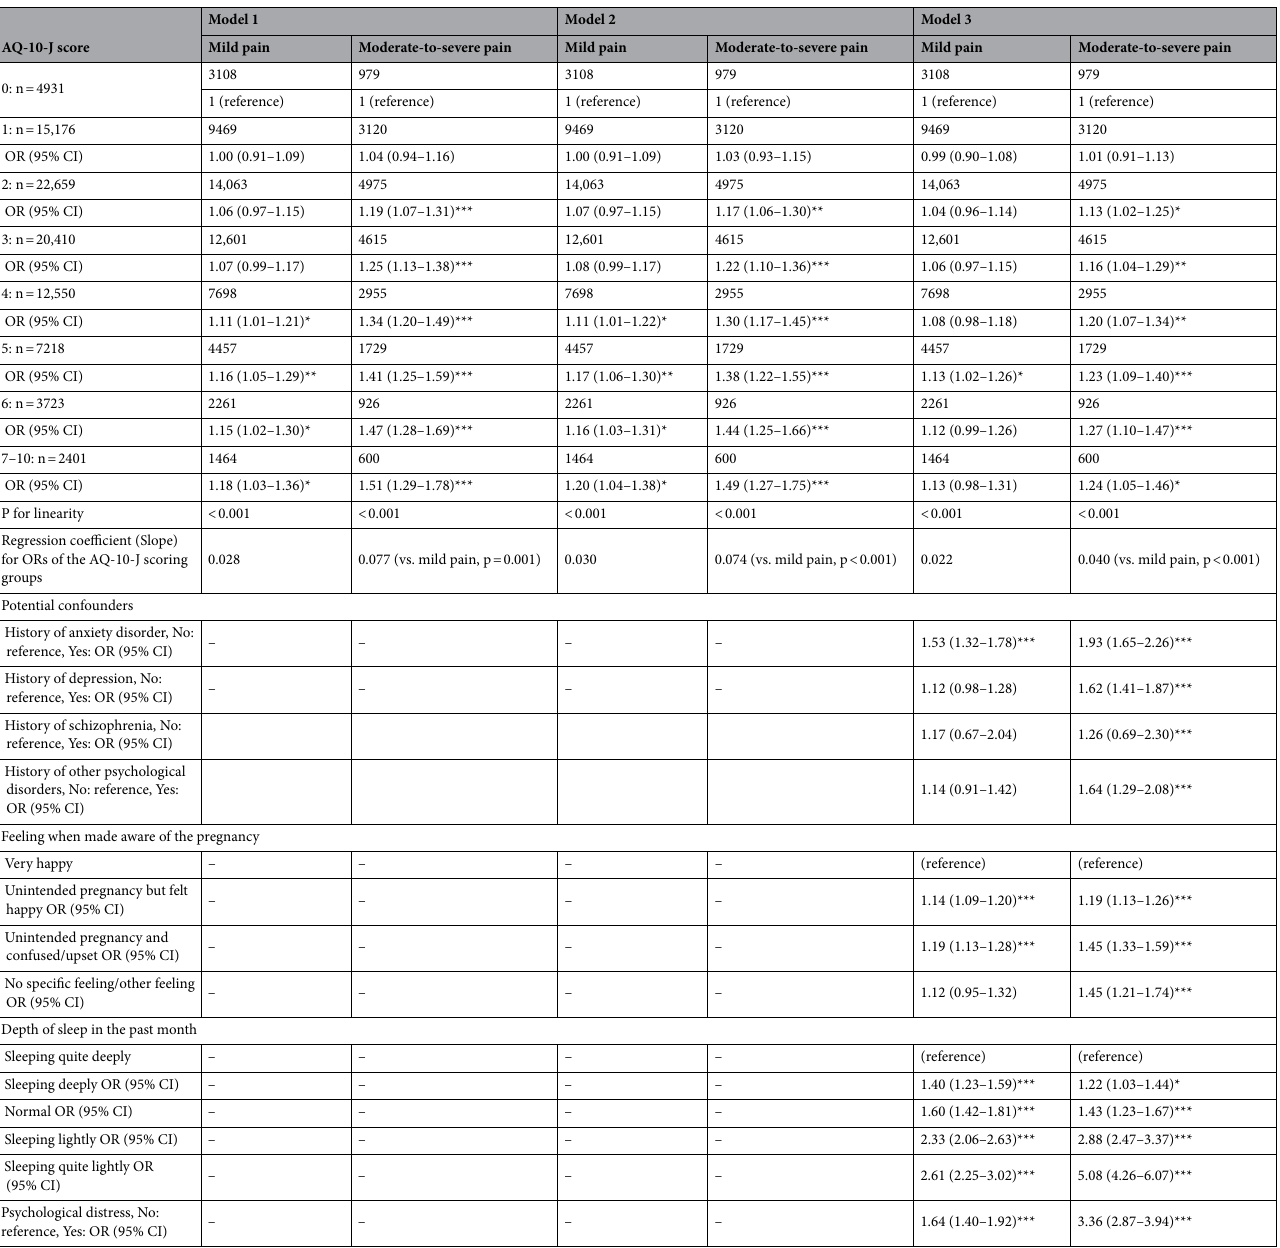
Table 2. Odds ratios (95% confidence intervals) for antenatal pain by Autism-Spectrum Quotient short form (Japanese version) scoring group. AQ-10-J Japanese version of the Autism-Spectrum Quotient short form, CI confidence interval, OR odds ratio. Model 1: Adjusted for age. Model 2: Adjusted for age, pre-pregnancy body mass index, smoking during pregnancy, drinking during pregnancy, physical activity, education, marital status, equivalized income, employment status, and multiple pregnancy. Model 3: Further adjusted for history of delivery, history of anxiety disorder, history of depression, history of schizophrenia, history of other psychological disorders, feeling when made aware of the pregnancy, sleep depth, and psychological distress during pregnancy. The Kessler Psychological Distress Scale (K6) score ≥ 13 was interpreted as indicating the presence of psychological distress during pregnancy. Odds ratio was estimated by multinominal logistic regression analysis. p for linearity for the ORs for mild and moderate-to-severe pain by increase in AQ-10-J score were estimated using a general linear model. Regression coefficients for the ORs in the AQ-10-J scoring groups (i.e., slopes) between mild pain and moderate-to-severe pain were also tested using a general